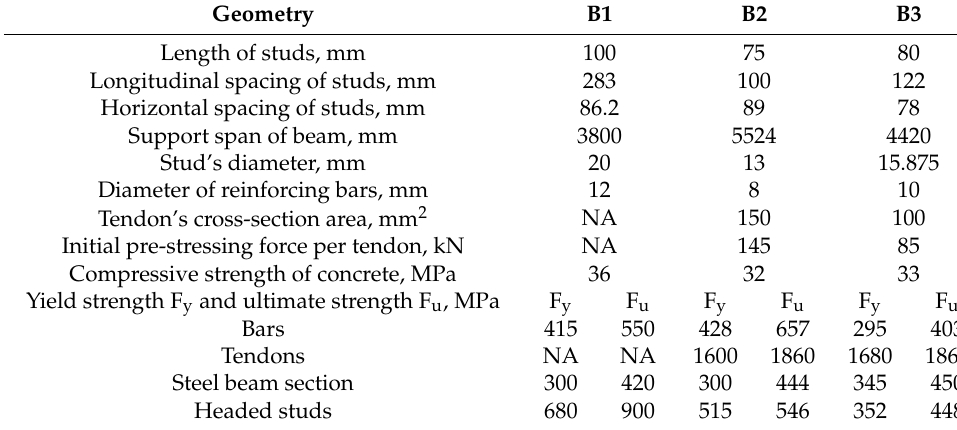
Table 2. Details of the different components of the composite girders and material